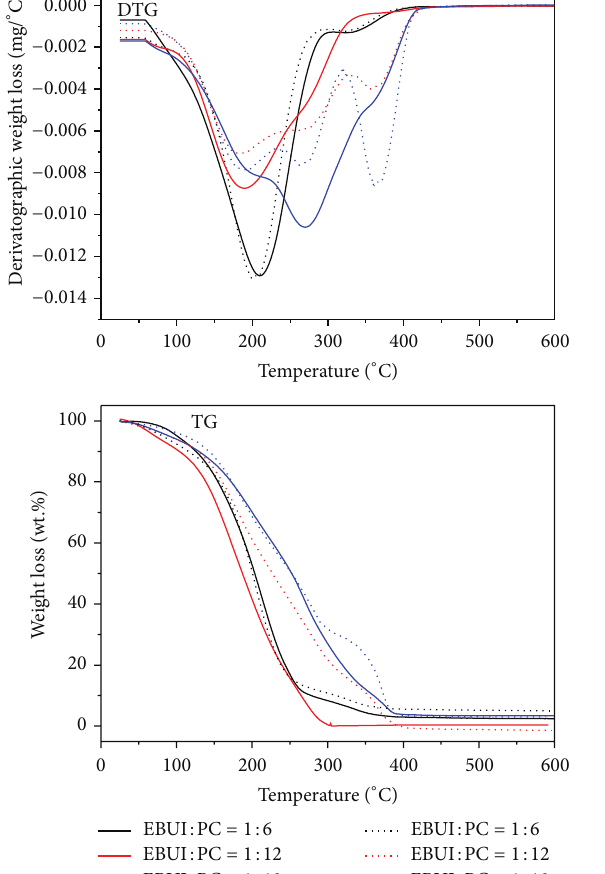
Table 4: Percentage of by-products in reaction products of EBU with PC.